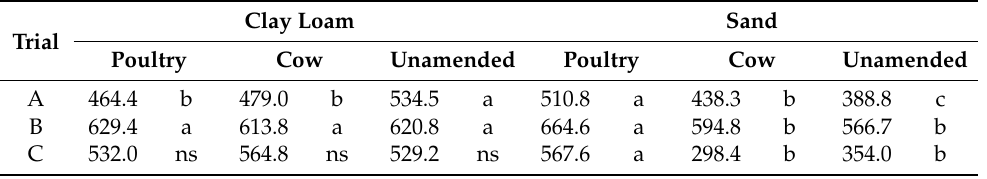
Table 6. Average head weight (g) of lettuce grown in clay loam or sandy soil, with the addition of poultry litter ( n = 48), dairy cow manure ( n = 48) or no amendment ( n = 24). Letters indicate means that are significantly different within rows ( p < 0.05); ns = not significantly